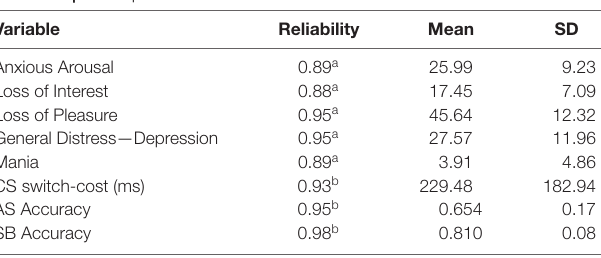
TABLE 5 | Descriptive statistics of model